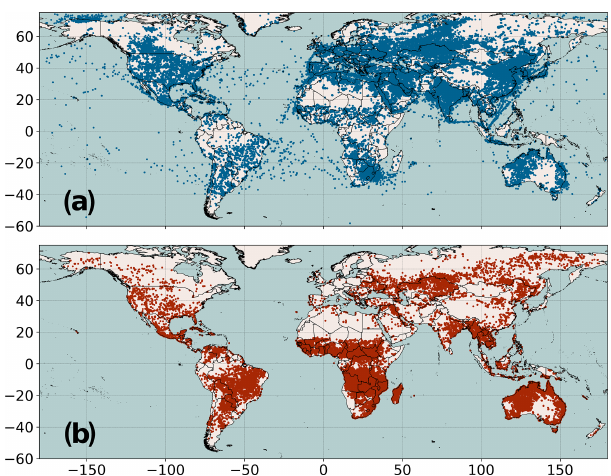
Figure 3. Geographical locations of individual TROPOMI NO 2 plumes identified using a CNN model, July 2018–June 2020. We attribute these plumes to (a) anthropogenic combustion or (b) biomass burning, depending on whether the plume falls within 15km of the nearest VIIRS thermal anomaly